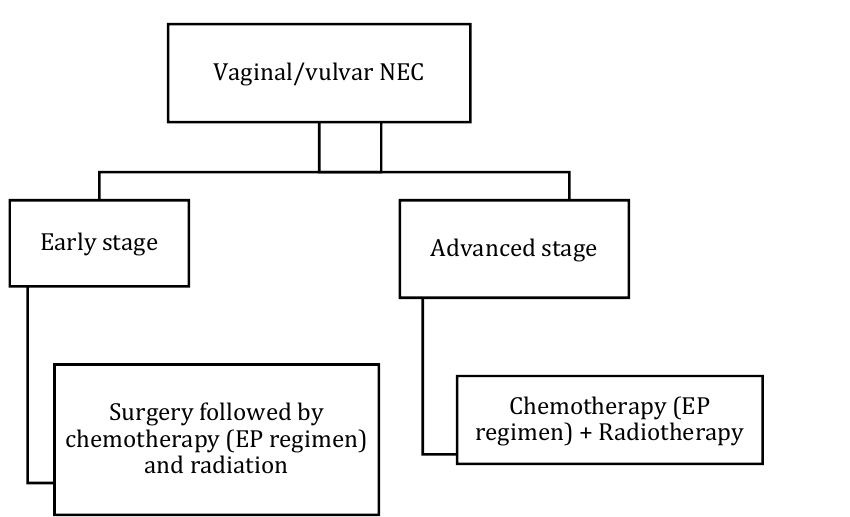
Figure 15. Treatment algorithm of vaginal/vulvar NEC. If non-surgical or metastatic disease: palliative chemotherapy with EP regimen or enrollment in clinical trials.